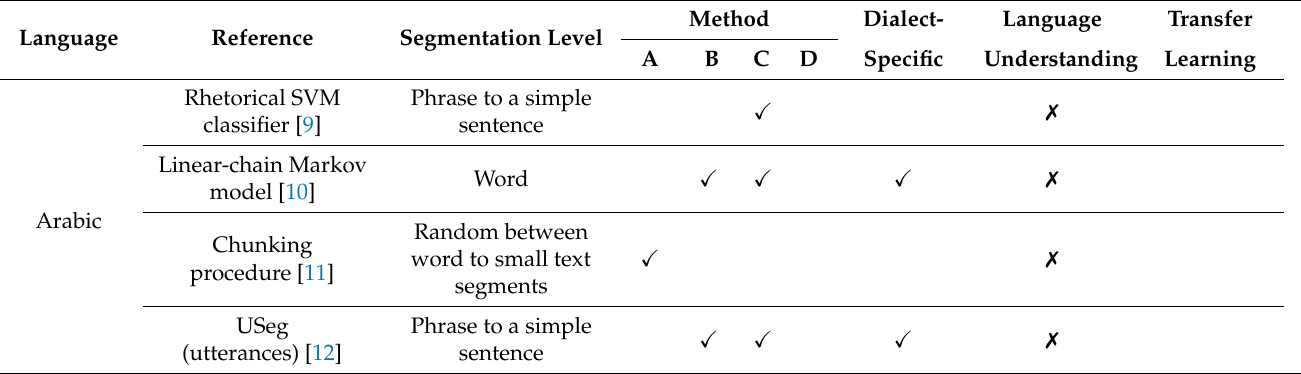
Table 1. A brief summary of text segmentation studies carried out for Arabic and English